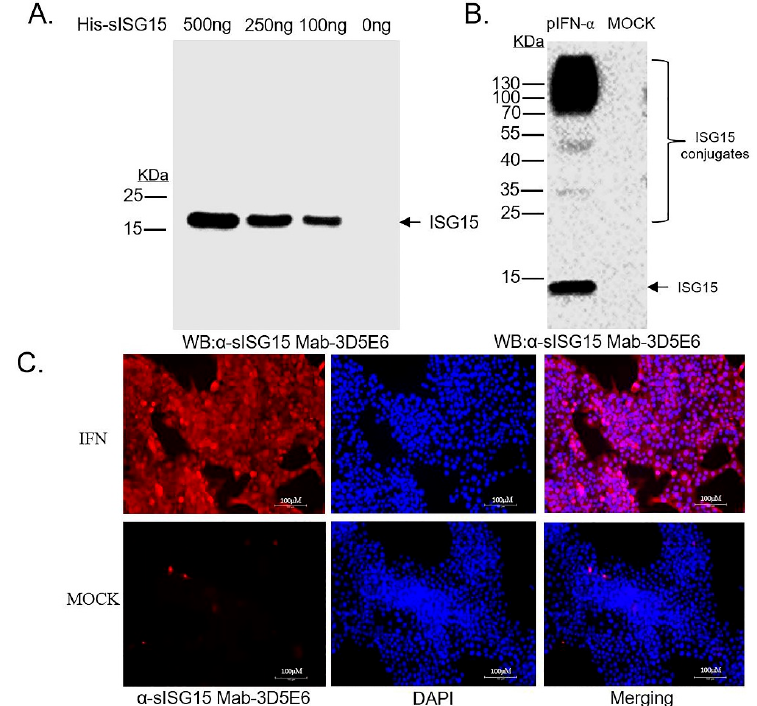
Figure 2. Development of Mab recognizing endogenous swine ISG15. ( A ) Recombinant expressed sISG15 protein with serial dilutions were subjected to Western blotting using the antibody present in hybridoma culture supernatant (clone no. 3D5E6) to detect binding of Mab-3D5E6 to its immunogen. ( B ) Cell lysates from CRL-2843 treated with or without porcine IFN- α (pIFN- α ) were harvested and subjected to Western blotting using the hybridoma culture supernatant (clone no. 3D5E6) to detect binding of Mab-3D5E6 to endogenous ISG15 in cell lines of swine origin. ( C ) CRL-2843 cells were either treated with pIFN- α or left untreated for 24 h. After cells were fixed and permeabilized, cells were incubated with Mab-3D5E6 followed by visualization after addition of Alexa Fluor ® 555-labeled goat anti mouse IgG (H + L) (Red channel) and counter-staining with DAPI.